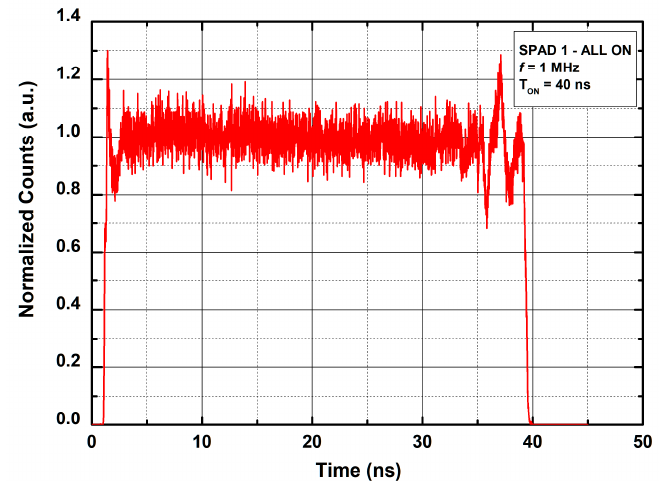
Figure 8. Final SPAD 1 photon counts distribution in a 40 ns ON-time gate at 1 MHz repetition rate when operating the SPAD array with 5 V excess bias voltage in dark conditions. The curve is normalized to its average value within the flat region of the optical gate window (i.e., from 5 to 30 ns).